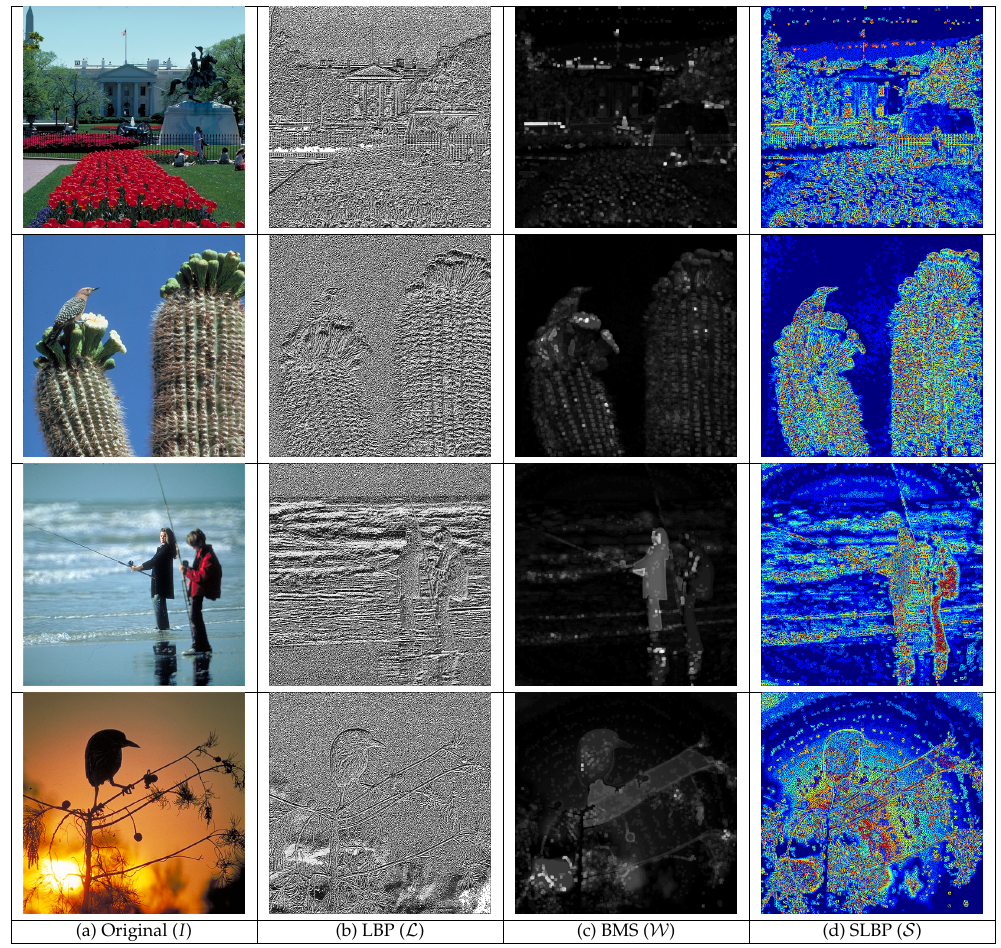
Figure 21. Example of original images ( a ), their LBP ( b ), BMS ( c ), and SLBP ( d )